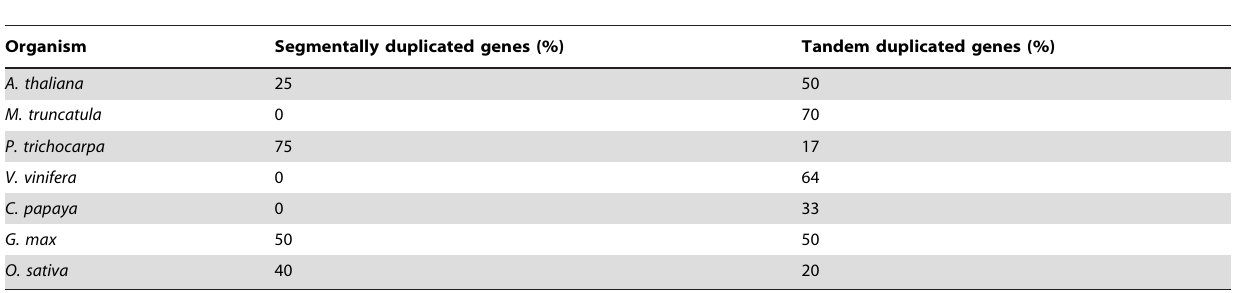
Table 2. Distribution of annexin genes in duplicated genomic regions in various plant